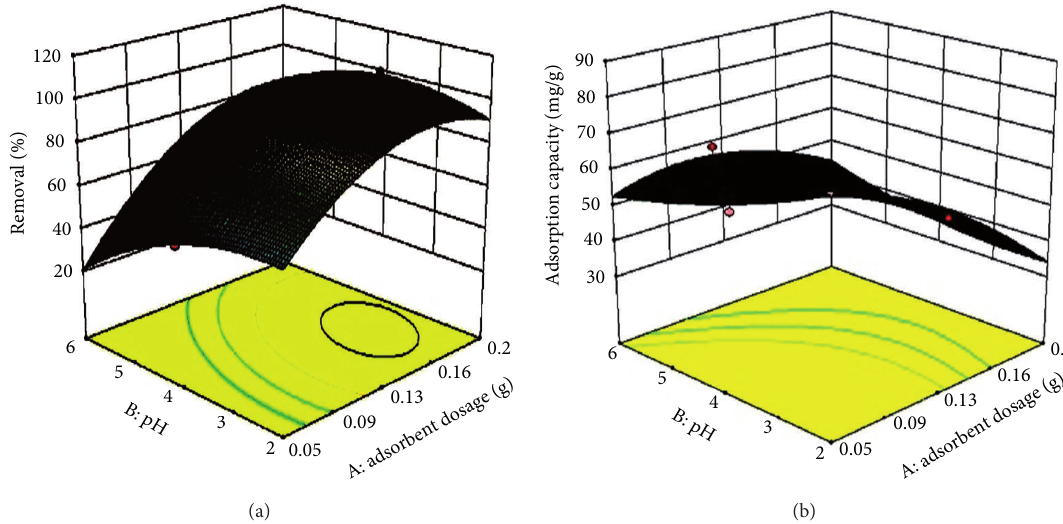
F 3: e combined effect of pH and adsorbent dosage on (a) percentage removal and (b) adsorption capacity of Cr(VI) ions using EAM-CCRCBs.